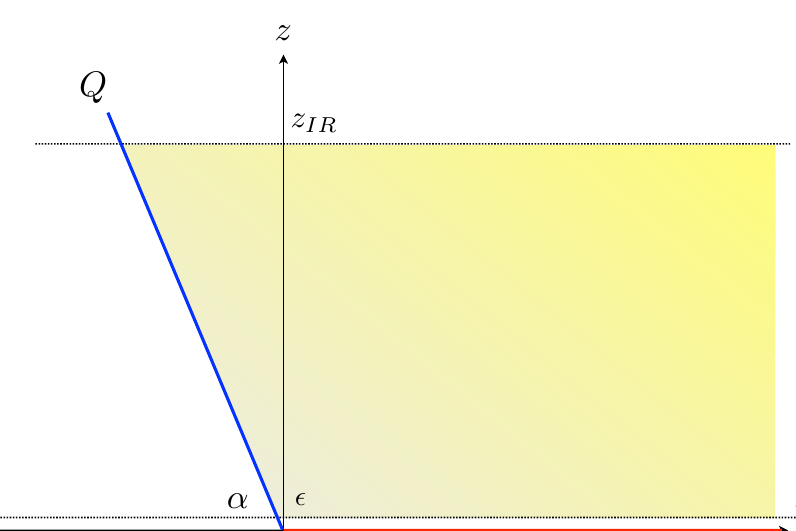
Figure 1 . Holographic CV complexity in the AdS 3 /BCFT 2 setup. The red half line corresponds to the constant time slice of the spacetime where the BCFT 2 is de(cid:12)ned. The holographic CV complexity (see section 2.2) is the volume of the yellow plane, delimited by the UV cuto(cid:11) (cid:15) , by the IR cuto(cid:11) z IR and by the brane Q (solid blue semi-in(cid:12)nite line). boundary-less case. On top of this, the result (2.8) for CV exhibits a subleading